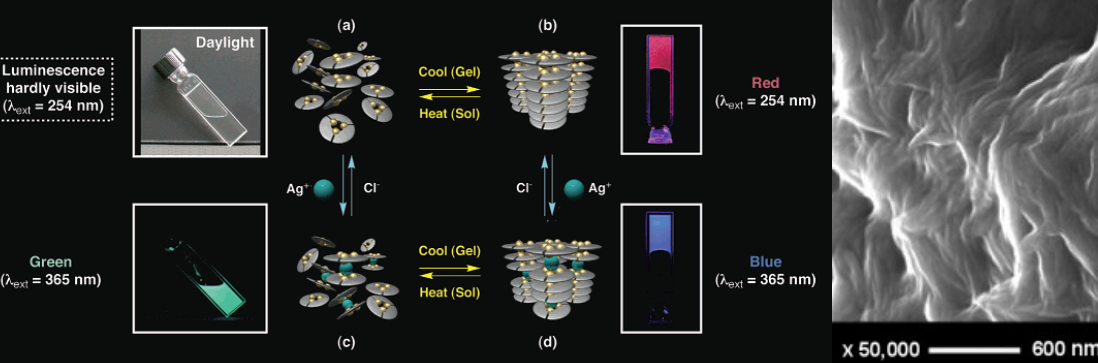
Figure 2. Luminescence profiles of Au(I) pyrazolate Complex 1 in hexane. Pictures and schematic self-assembling structures; ( a ) sol, ( b ) gel, ( c ) sol containing AgOTf (0.01 equiv), and ( d ) gel containing AgOTf (0.01 equiv), ( left ); Field-emission scanning electron micrographs (FE-SEM) of an air-dried gel (xerogel) with 1 , spattered with Pt under an electric current of 15 mA at 10 Pa for 10 s ( right ). Adapted with permission from ref. [27]. Copyright 2005 American Chemical